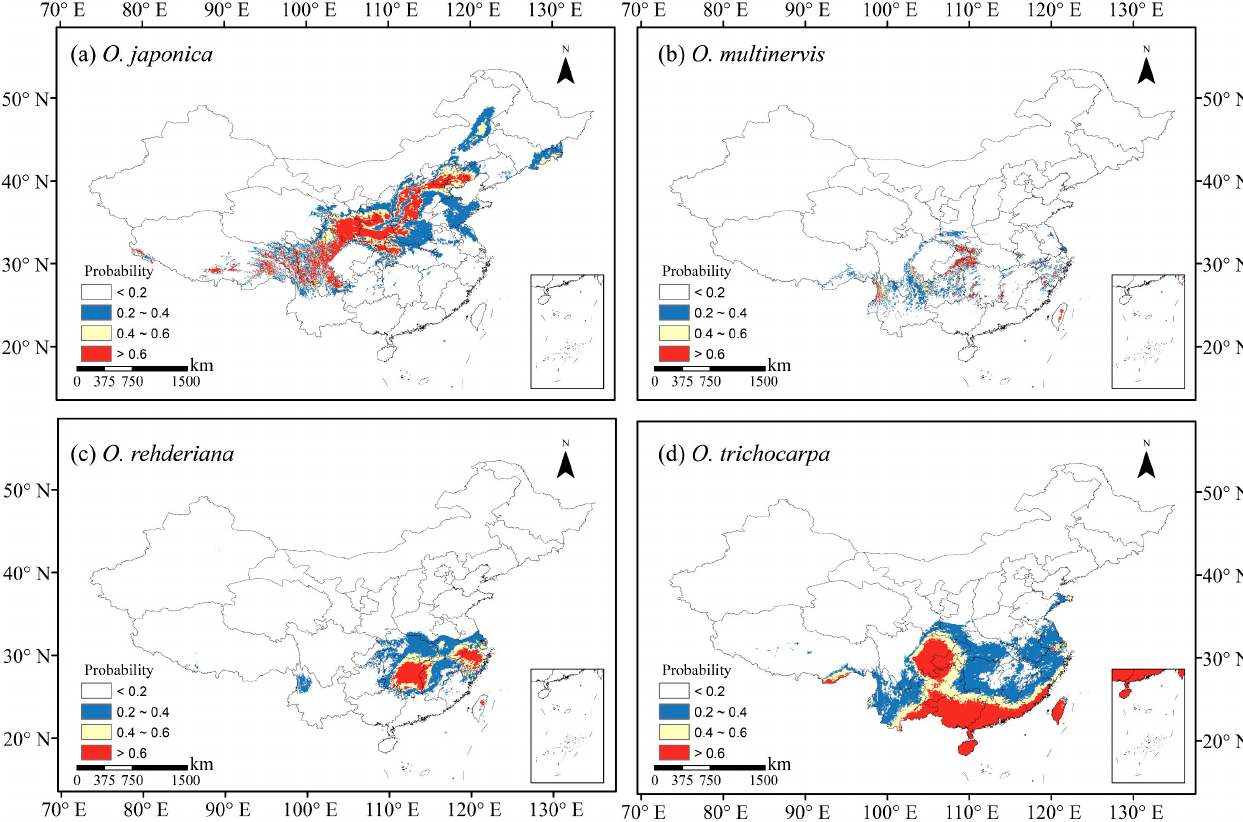
Figure 3. Potential habitats of four Ostrya species, i.e., O. japonica ( a ), O. multinervis ( b ), O. rehderiana ( c ), and O. trichocarpa ( d ), under the climate scenario BCC-CSM2-MR SSP1-2.6 in the period 2081–2100. The values for species occurrence probability ranged between 0 and 1, i.e., least potential (<0.2), moderate potential (0.2–0.4), good potential (0.4–0.6), and high potential (>0.6).